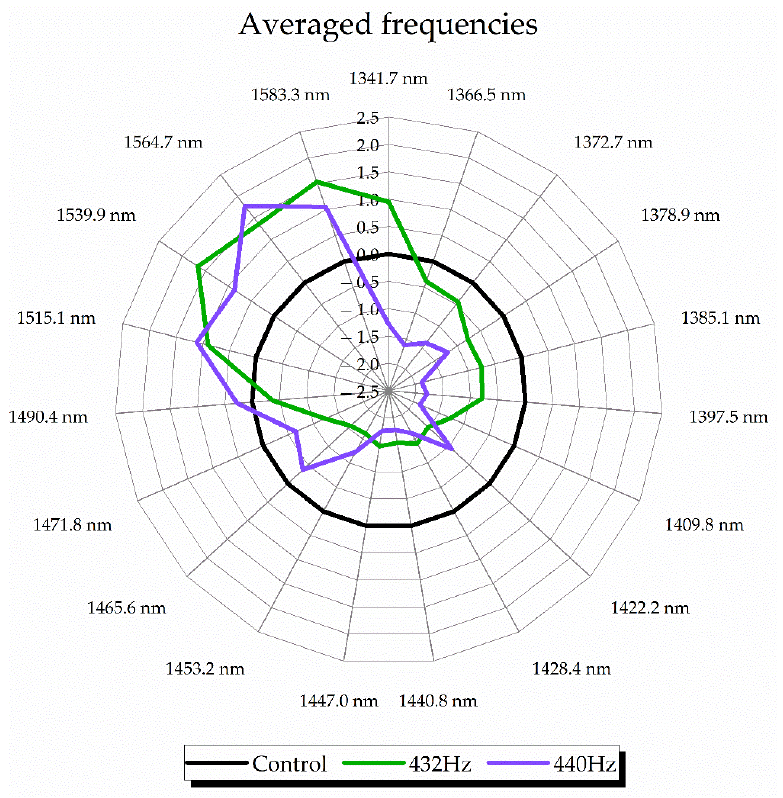
Figure 6. Aquagrams showing average WASPs of water perturbed by sound with 432 Hz and 440 Hz frequencies.